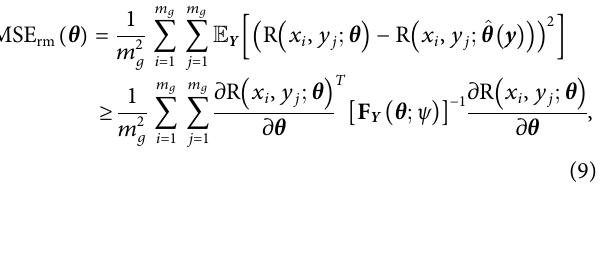
Frontiers in Signal Processing |